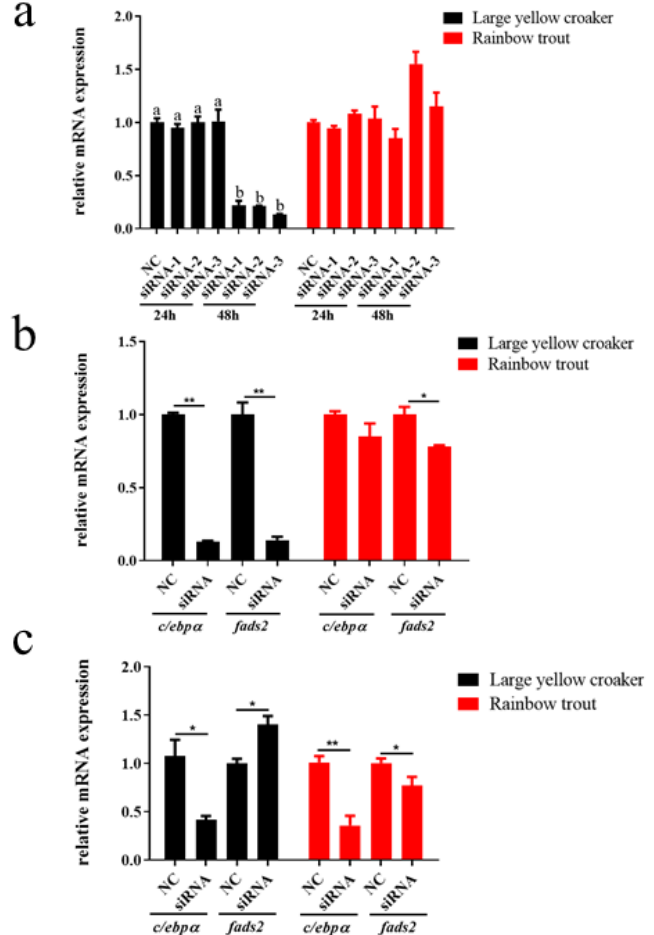
Figure 7. Effects of small RNAi on expression of c/ebp α , gata3 , and its potential target genes fads2. Selection of siRNA to target the C/EBP α gene at different time points ( a ), the relative expression and fads2 under the influence of siRNA-1 in rainbow trout and siRNA-3 in large yellow croaker for 48 h ( b ), the relative expression of gata3 and fads2 under the influence of siRNA in rainbow trout and large yellow croaker for 24 h ( c ). Values are presented as mean ± SEM ( n = 3). Bars without sharing a common letter are significantly different ( p < 0.05). The “*” means a significant difference ( p < 0.05) and “**” means a highly significant difference ( p < 0.01).